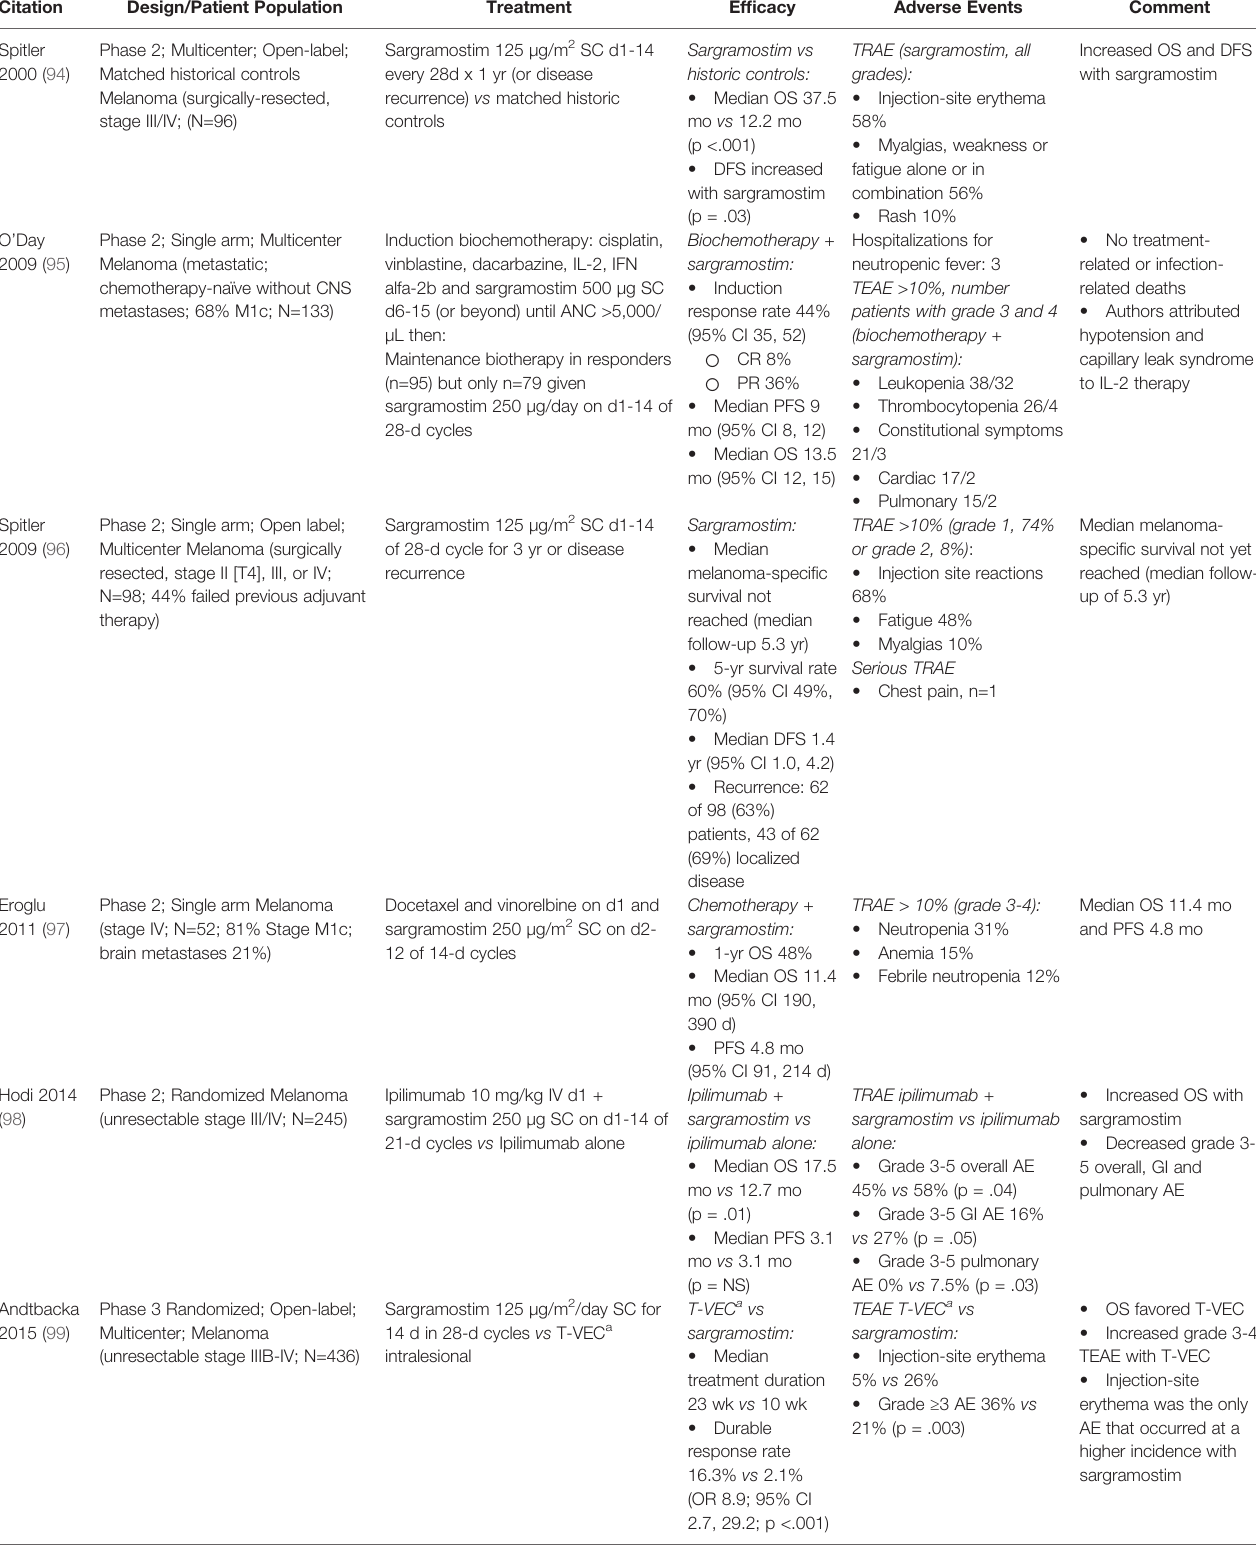
TABLE 2 | Clinical studies evaluating immune-enhancing effects of sargramostim in melanoma.